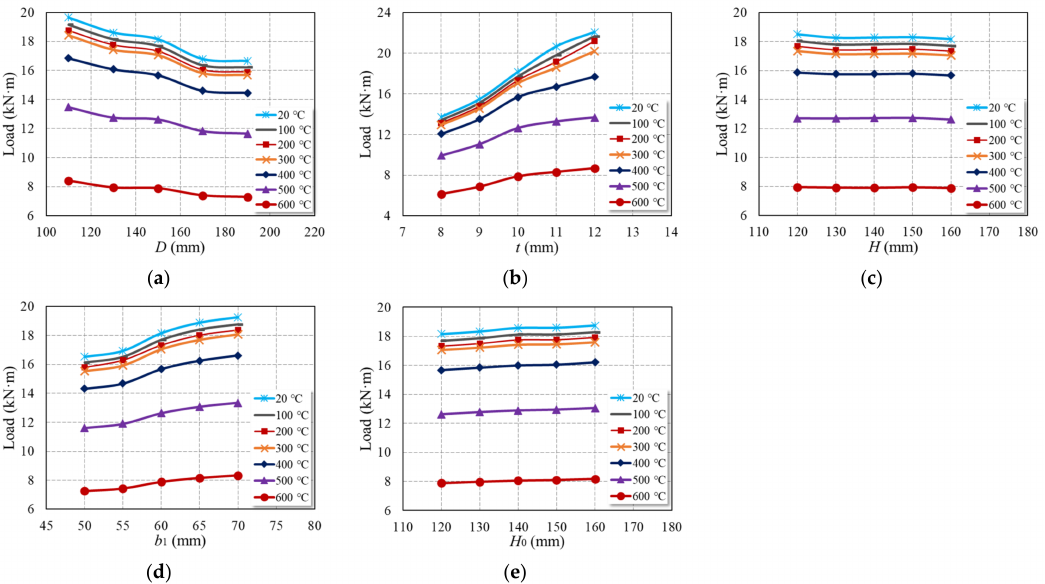
Figure 19. Effects of parameters on the load-carrying capacity of BBC joints under negative bending: ( a ) outer diameter of the tube; ( b ) thickness of the tube; ( c ) height of the tube; ( d ) width of the tubular beam; ( e ) height of the tubular beam.